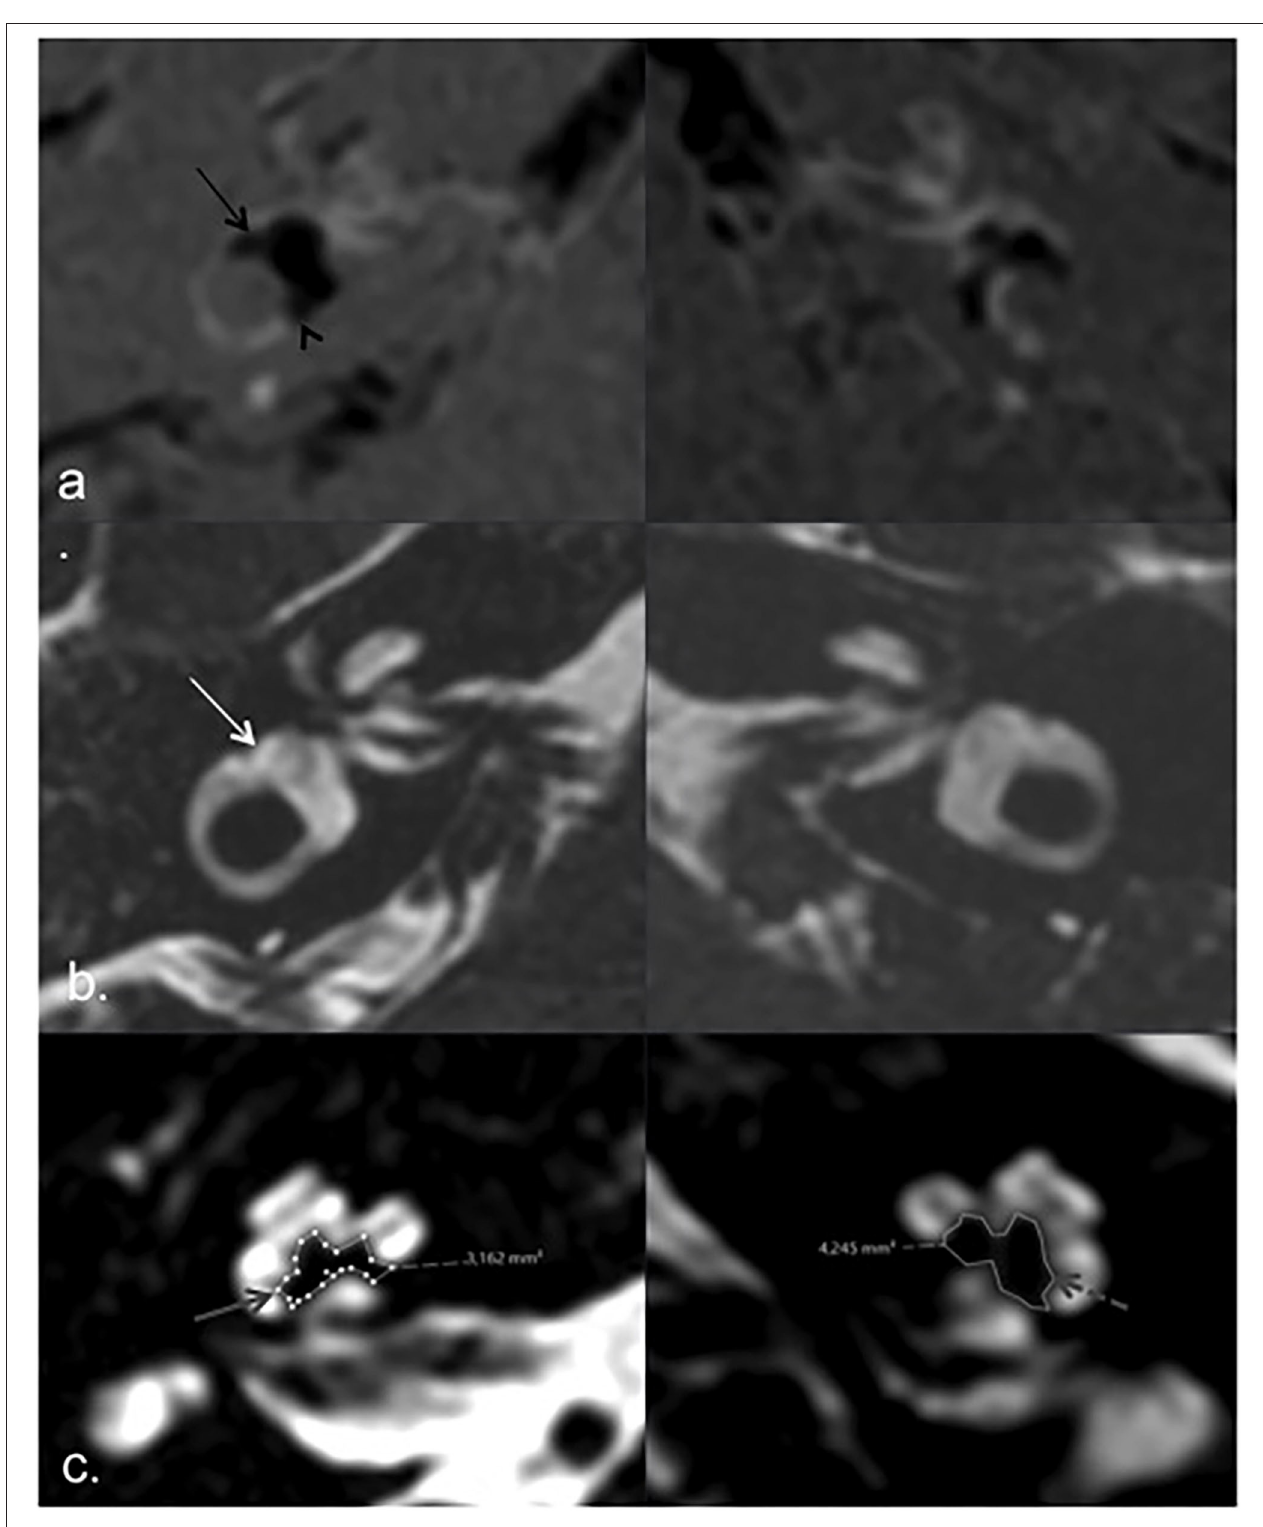
FIGURE 3 | MRI of patient 2. HYDROPS (a) and T2 3D TSE (b) axial images according to lateral semicircular canal plane, showing endolymphatic (black arrows) and total vestibular labyrinth (white arrow) respectively. Extreme right vestibular endolymphatic hydrops with herniation of endolymph into de ampullary (black arrow) and non-ampullary (black arrowhead) endings of the lateral semicircular canal in right ear (index ear). Axial T2 image according to the greater axis of cochlear modiolus (c) , showing marked asymmetric modiolar areas, smaller on the right side (solid gray arrow) compared to the left asymptomatic side (dashed gray arrow).